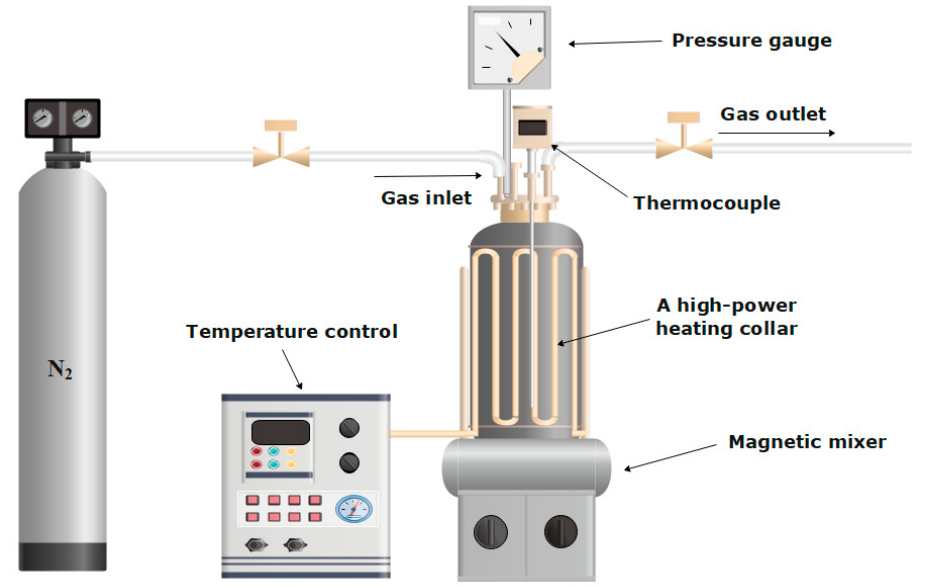
Figure 1. A batch reactor system of SubCW